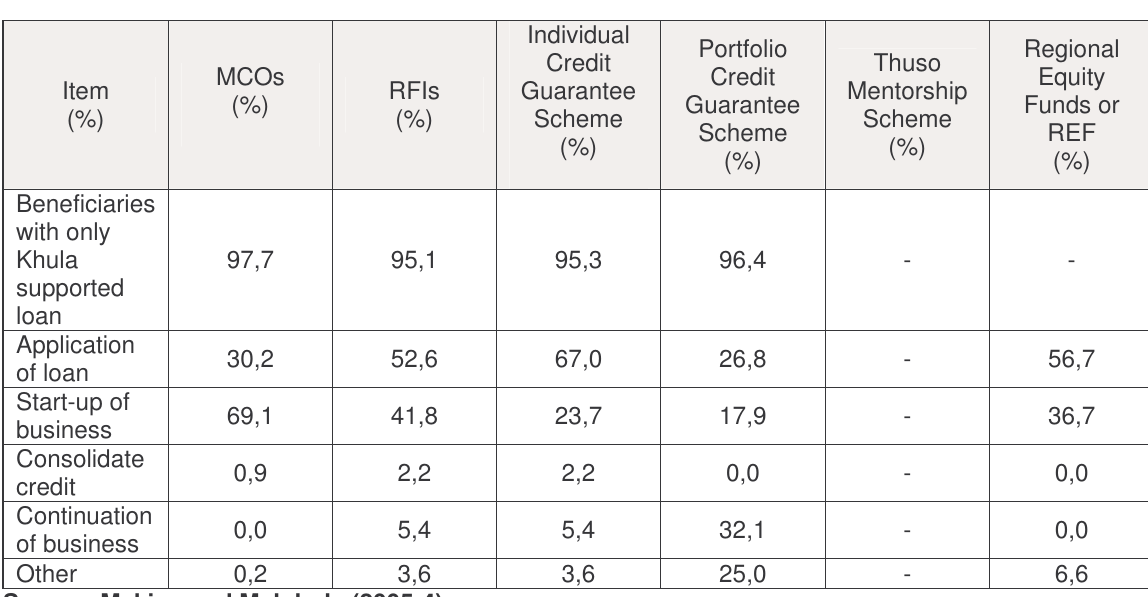
Table 4: Loan features - 1996 to